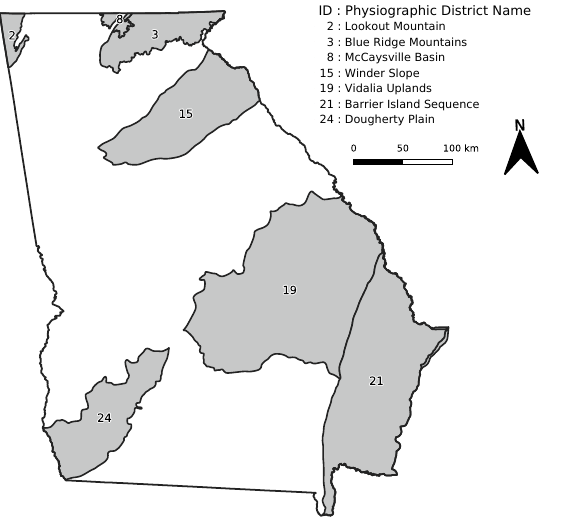
Figure 2. All physiographic districts used for the case study. For computational time comparisons, McCaysville Basin, Lookout Mountain, Dougherty Plain, Winder Slope, Barrier Island Sequence, and Vidalia Uplands districts were used. For classification quality comparisons, the Blue Ridge Mountains district was used.